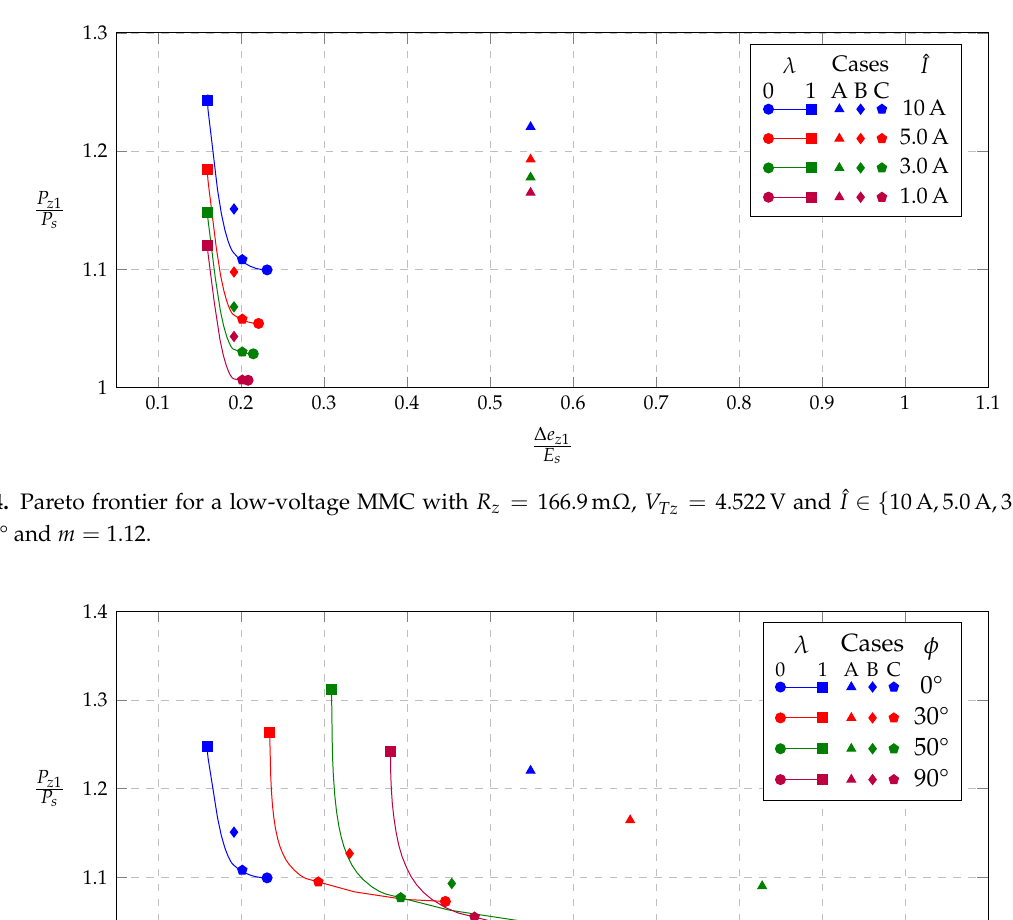
Figure 5. Pareto frontier for a low-voltage MMC with R z = 166.9m Ω , V Tz = 4.522V and ˆ I = 10A at φ and m =